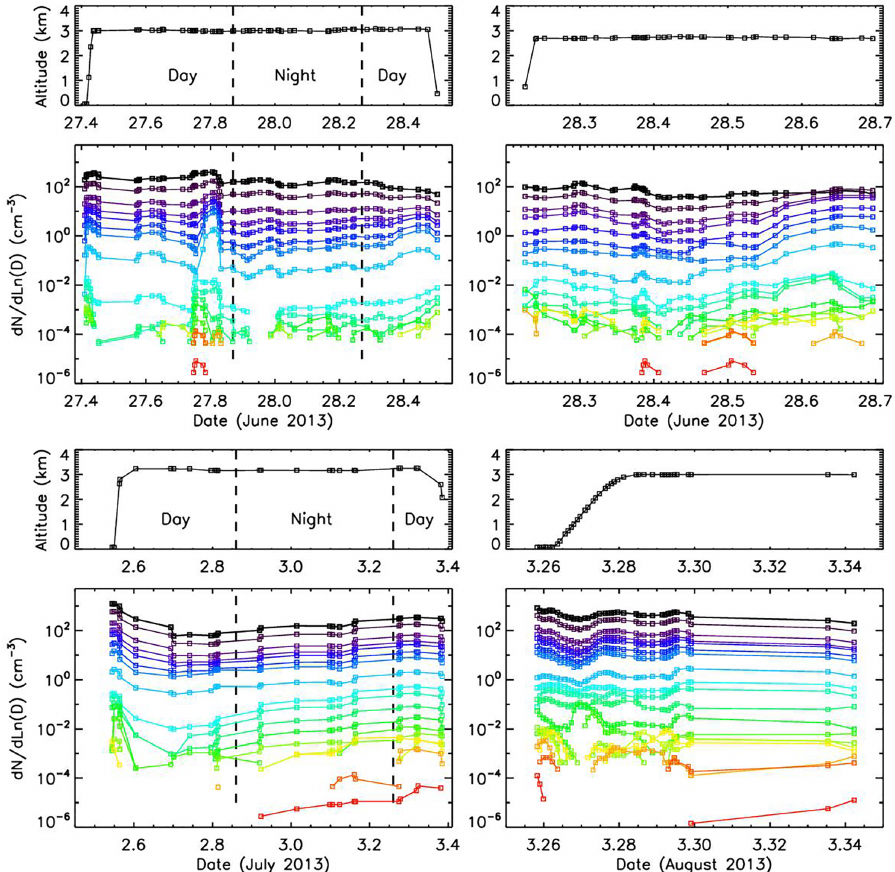
Figure 14. Each pair of graphs represents the time series of flight altitude (top) and LOAC-derived aerosol concentration for the 19 size classes (bottom), for BLPB flights from Minorca towards the French coast. Colour coding is as in Fig. 7. Day–night transitions are indicated by dashed lines when appropriate.